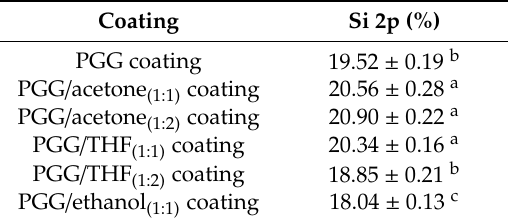
Figure 5. X-ray photoelectron spectroscopy of Si 2p profiles for different coatings. Table 2. XPS Elemental Analyses of different coatings. Results are mean ± standard deviations of duplicate analysis. Values followed by different letters in the same line are significantly different ( p ≤ 0.05, N = 3).